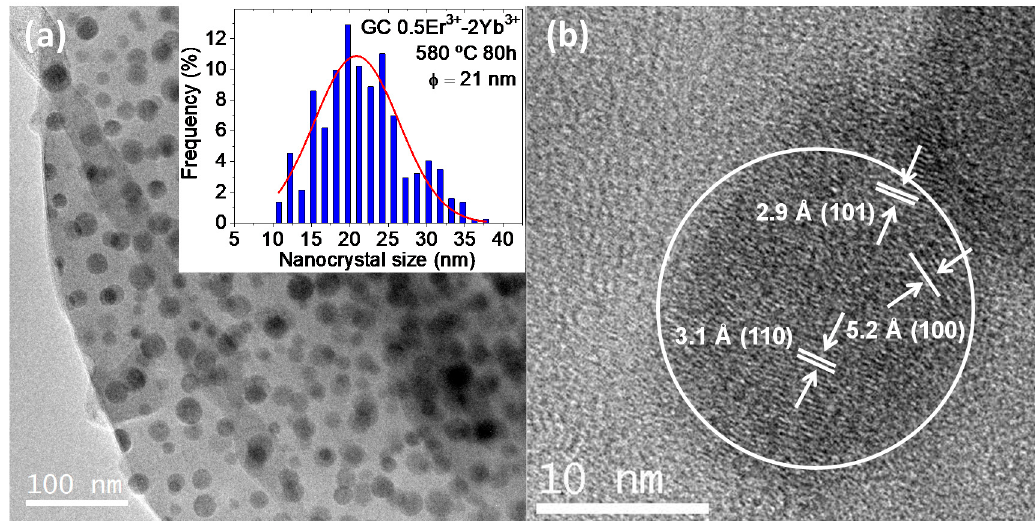
Figure 3 . ( a ) TEM micrograph of 0.5Er 3+ –2Yb 3+ -codoped 70Si7Gd GCs treated at 580 °C-80 h. Inset, corresponding NCs size distribution; ( b ) HRTEM micrographs of the NCs with the different interplanar distances associated with the NaGdF4 structure.